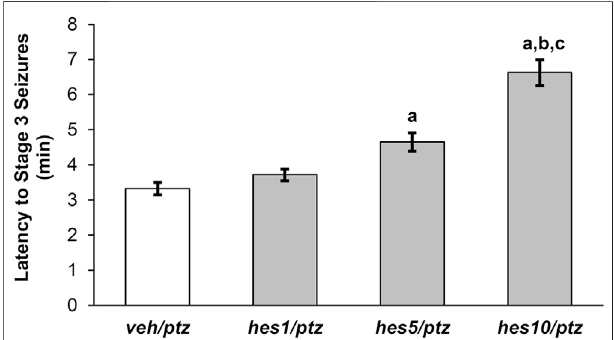
FIGURE 4 | Effect of hesperidin on the latency to PTZ-induced seizures (Stage 3). veh/naïve group was not exposed to PTZ, hence not shown in the fi gure. a P < 0.05 as compared to veh/ptz (vehicle control) group; b P < 0.05 as compared to hes1/ptz group and; c P < 0.05 as compared to hes5/ptz group. The results expressed as mean ± SEM. veh/ptz : system water incubated group exposed to PTZ; hes1/ptz : Hesperidin 1 μ M incubated groupexposedtoPTZ; hes5/ptz :Hesperidin5 μ Mincubatedgroupexposed to PTZ and; hes10/ptz : Hesperidin 10 μ M incubated group exposed to